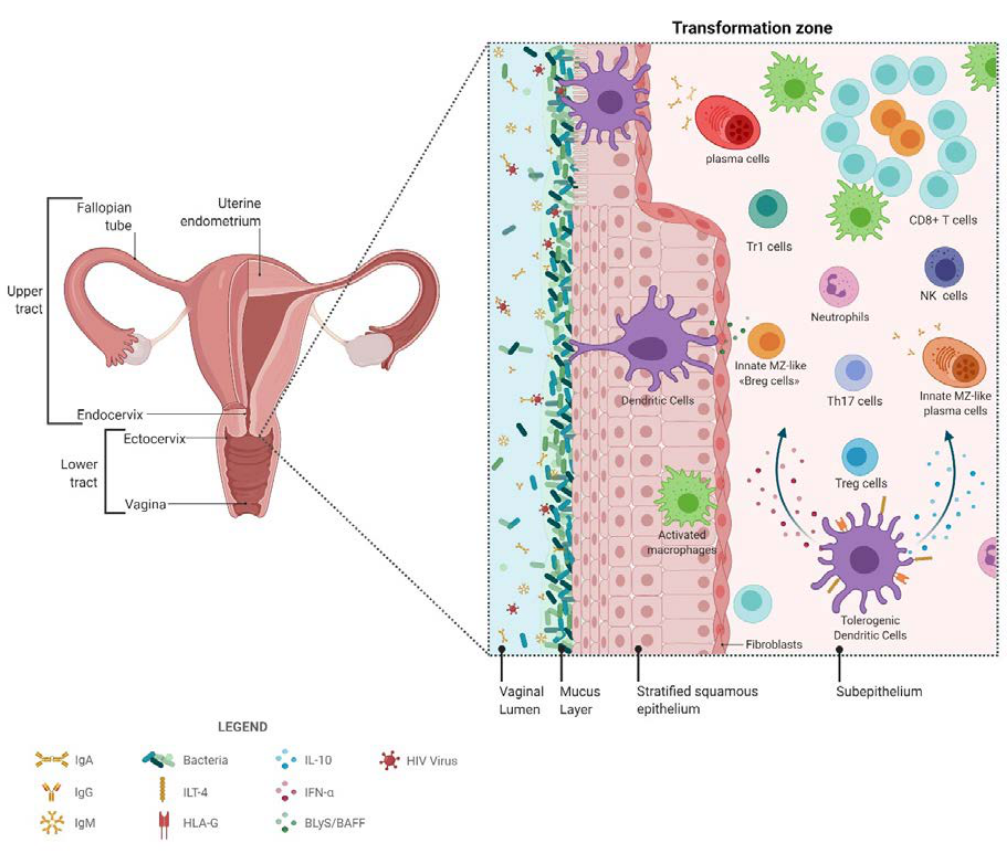
Figure 1. Active players in natural immunity to